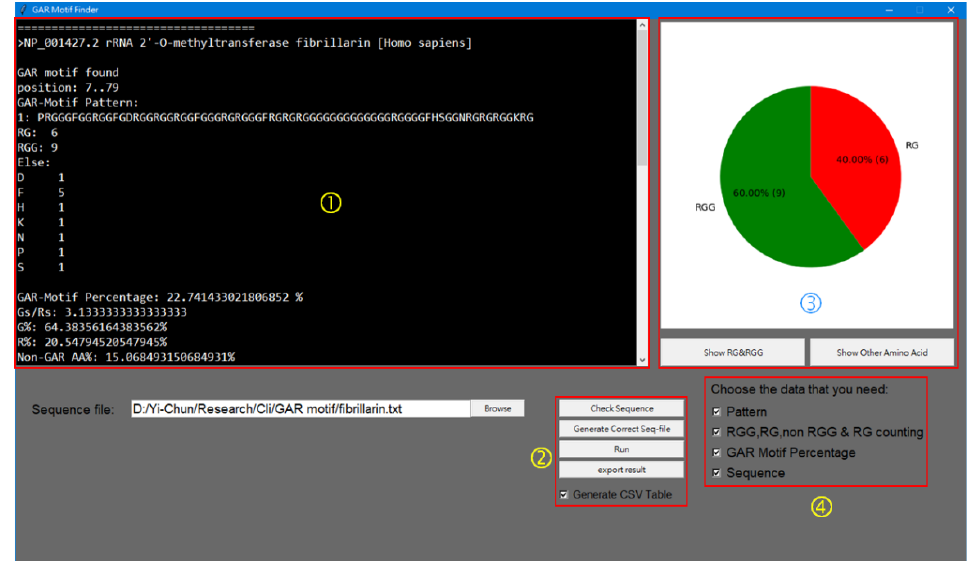
Figure 1. The interface of GMF. Red box 1 (cid:13) is the information window to show the events of any operation. Red box 2 (cid:13) is the function button panel. Red box 3 (cid:13) is the graphic window to display the pie or bar charts. Red box 4 (cid:13) CIRCLED is the check box to select the data to be